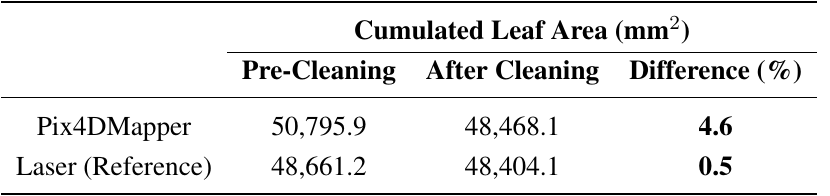
Table 1. Example of the influence of cleaning on the cumulated leaf